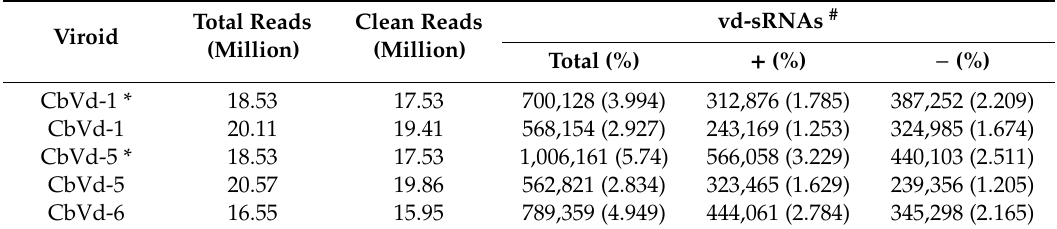
Table 1. Number of sequencing reads of coleus blumei viroid (CbVd)-1-, -5-, and -6-derived small RNAs